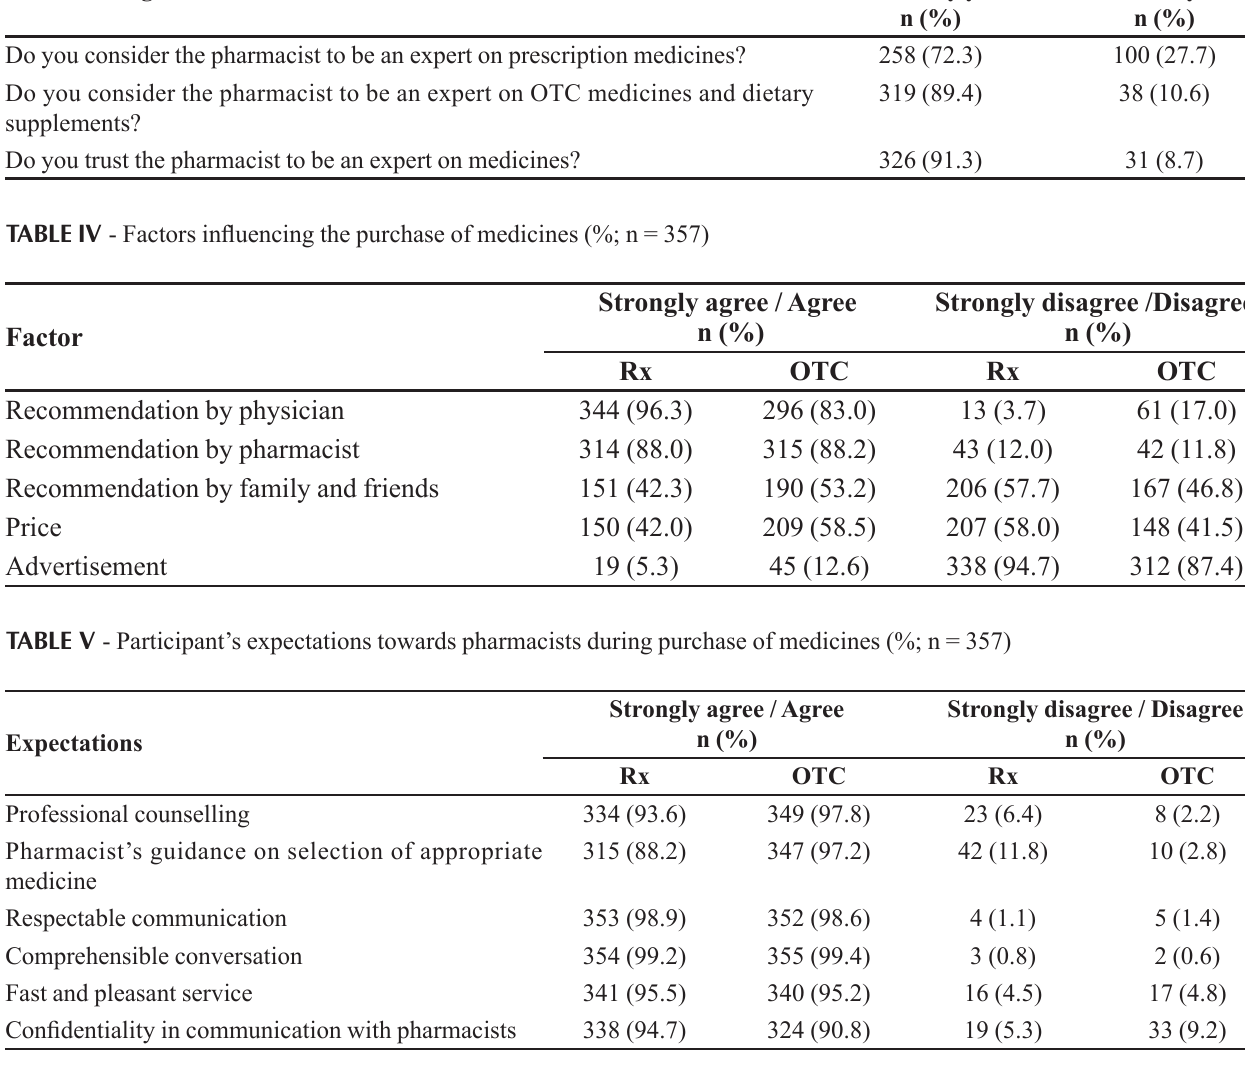
Level of recognition